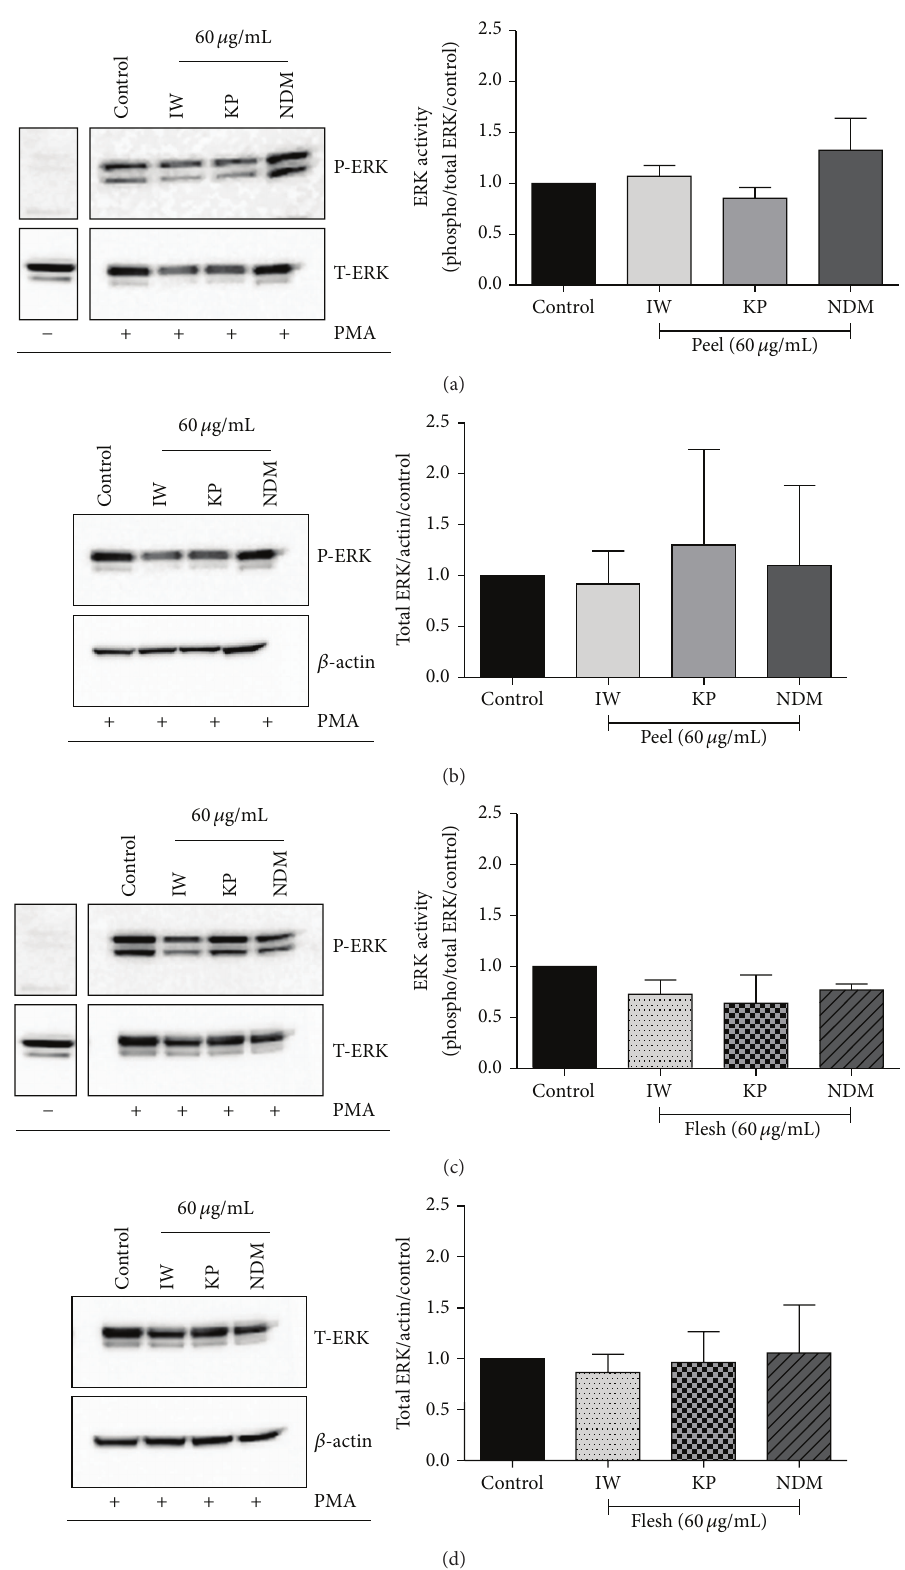
Figure 2: ERK activation in MCF-7 tumour cells. The phosphorylation of ERK (P-ERK) ((a) and (c)) and normalisation of total ERK (T- ERK) ((b) and (d)) in lysates from cells treated with peel and flesh extracts from mango cultivars IW, KP, and NDM were determined by immunoblotting. Bar graphs indicate quantification of at least 3 separate blots using Quantity One software. Data are expressed as mean ± SE. ∗ 𝑃 ≤ 0.05 , significant difference from PMA-treated controls ( 𝑛 ≥ 3